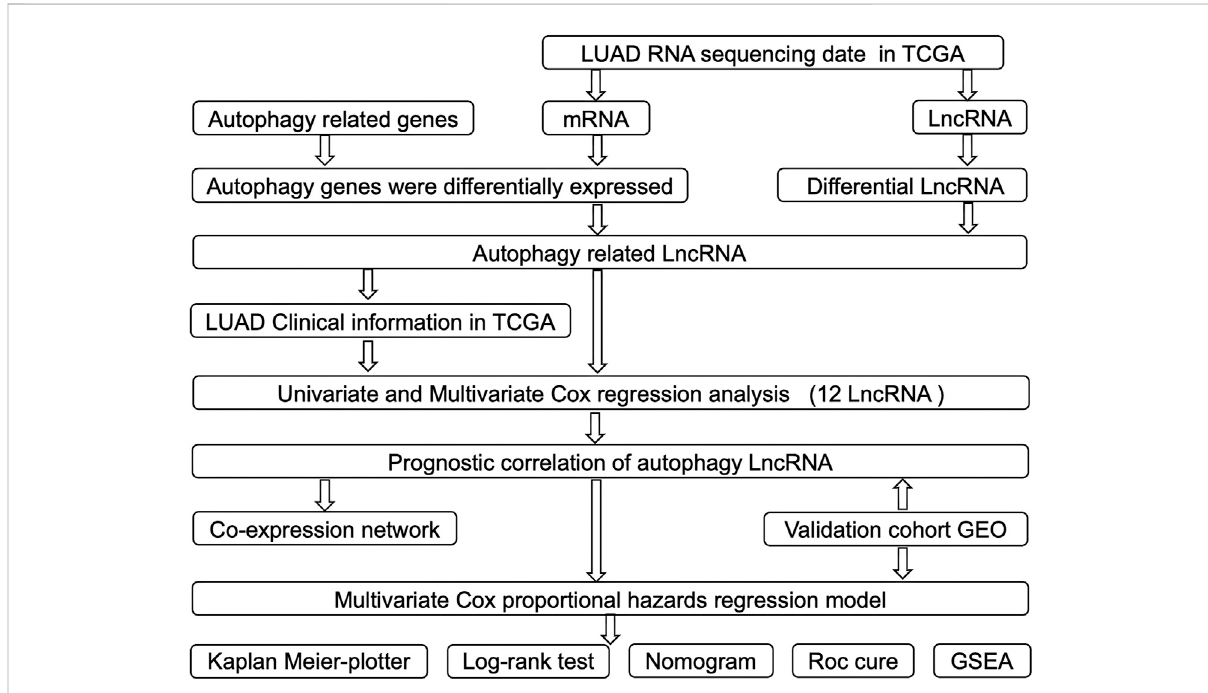
FIGURE 1 Flowchart of construction and validation of lncRNA risk signature and nomogram incorporating clinical